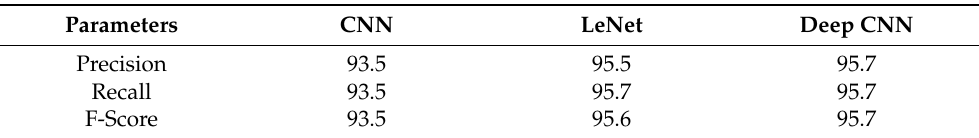
Table 5. Precision, Recall, and F 1 -Score Comparison of CNN, LeNet, and Deep CNN Models on the Pashto Character Dataset.